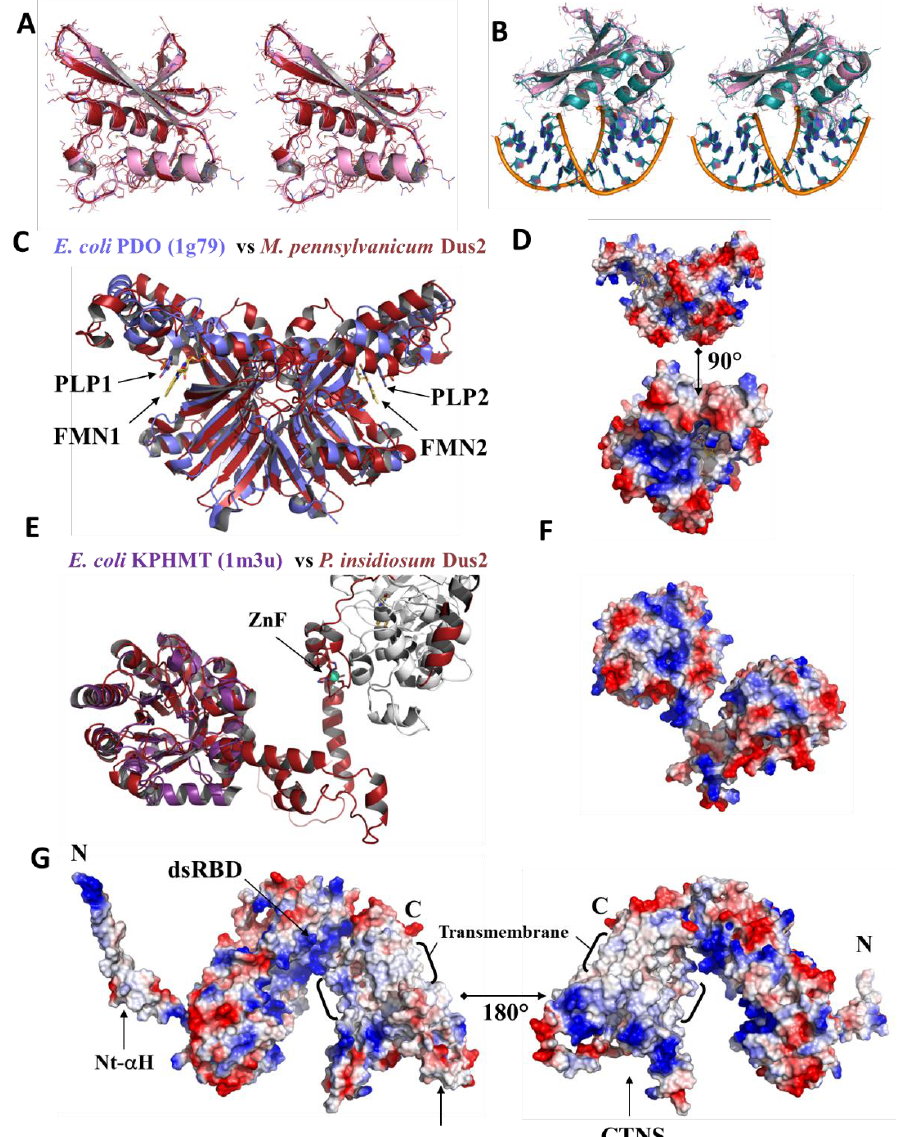
Figure 8. Structural analysis of various Dus2 domains. ( A ) Stereoview of the structural superimposition of the crystal structure of the dsRBD of A. queenslandica Dus2 (colored in pink) with the dsRBD obtained from the 3D model of A. queenslandica Dus2 (colored in red) generated by AlphaFold2. The side chains are shown as lines. ( B ) Stereoview of the structural superimposition of the crystal structure of the dsRBD of A. queenslandica Dus2 (colored in pink) with the crystal structure of the hDus2 dsRBD (colored in deep teal) in complex with a dsRNA (PDB: 5OC6). The backbone of the dsRNA is orange, while the nucleosides are deep teal. ( C ) Structural superimposition of the PyrOx domain of M. pennsylvanicum from the Dus2 model with the X-ray structure of the dimer of E. coli pyridoxine 5 ’ -phosphate oxidase complexed with pyridoxal 5 ’ -phosphate (PLP) and flavin mononucleotide (FMN) (PDB: 1G79). The dimer of PyrOx generates two equivalent active sites, each containing a PLP and an FMN. PyrOx of Dus2 and 1G79 are in red and purple, respectively. The FMN and PLP represented as sticks are in yellow and purple, respectively. ( D ) Electrostatic surface of PyrOx domain of M. pennsylvanicum Dus2. ( E ) Structural superimposition of the KPHMT domain of P. insidiosum from the Dus2 model (in red) with the crystal structure of ketopantoate hydroxymethyltransferase complexed the product ketopantoate (PDB: 1M3U, colored in violet). ( F ) Electrostatic surface of the KPHMT domain of P. insidiosum from the Dus2 model. ( G ) Electrostatic surface of Dus2 model from T. nelsoni